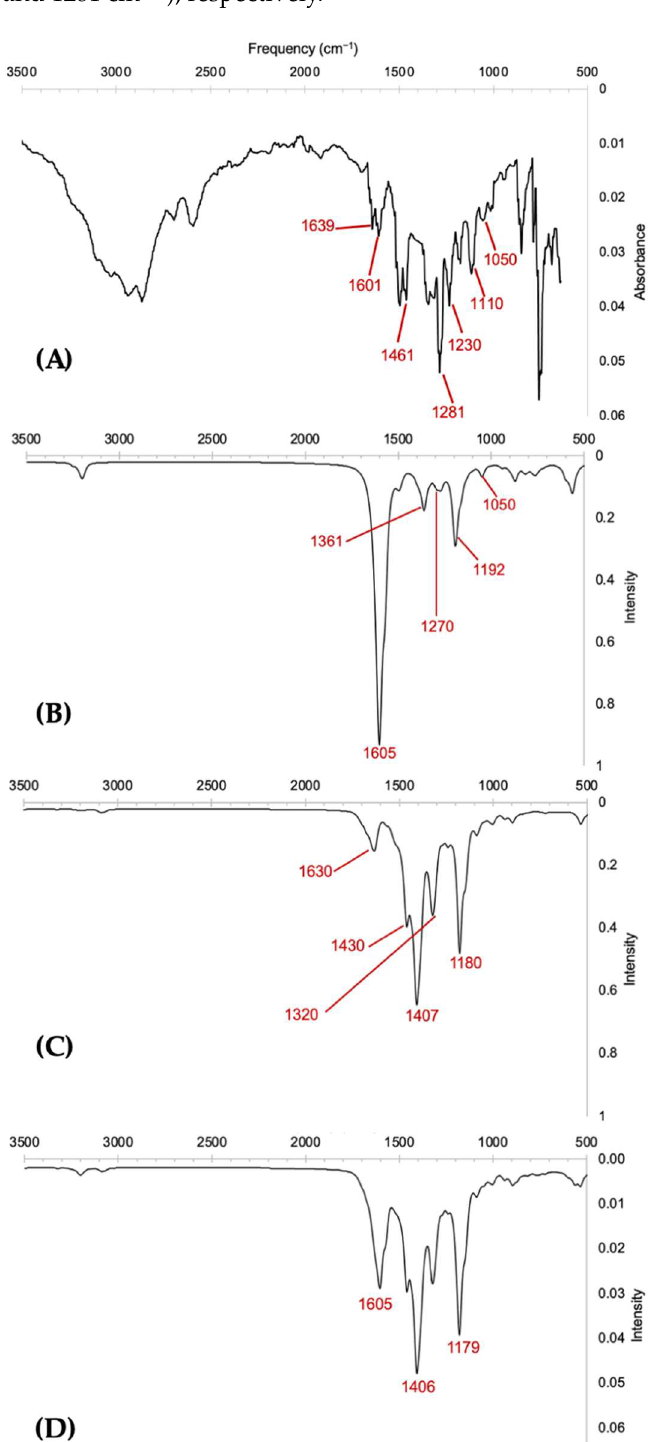
Figure 3. ( A ) Experimental spectra of PoAP (after DBD plasma treatment) obtained via attenuated total reflection [8]. ( B ) Theoretical spectra for quinoid PoAP trimer. ( C ) Theoretical spectra for keto PoAP trimer. ( D ) Simulated spectra comprised of 27% quinoid and 73% keto PoAP